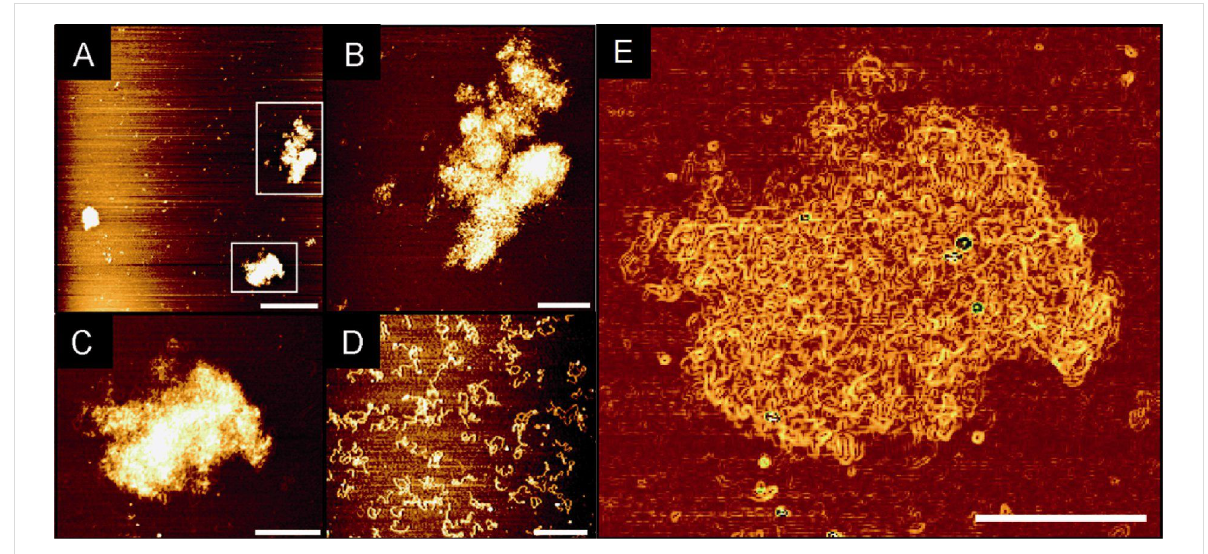
Figure 4: AFM analysis of DNA structures: (A) Overview-scan 10 × 10 µm showing DNA networks generated after 28 cycles with 66 °C annealing temperature (bar is 2 µm). (B, C) Zoom in picture of DNA network (all bars are 0.5 µm, respectively). (D) AFM when non-branched primers were employed (bar is 0.5 µm). (E) Software analysis of AFM measurement taking first derivative of height channel. DNA network generated after 28 cycles with 66 °C annealing temperature (bar is 0.5 µm).